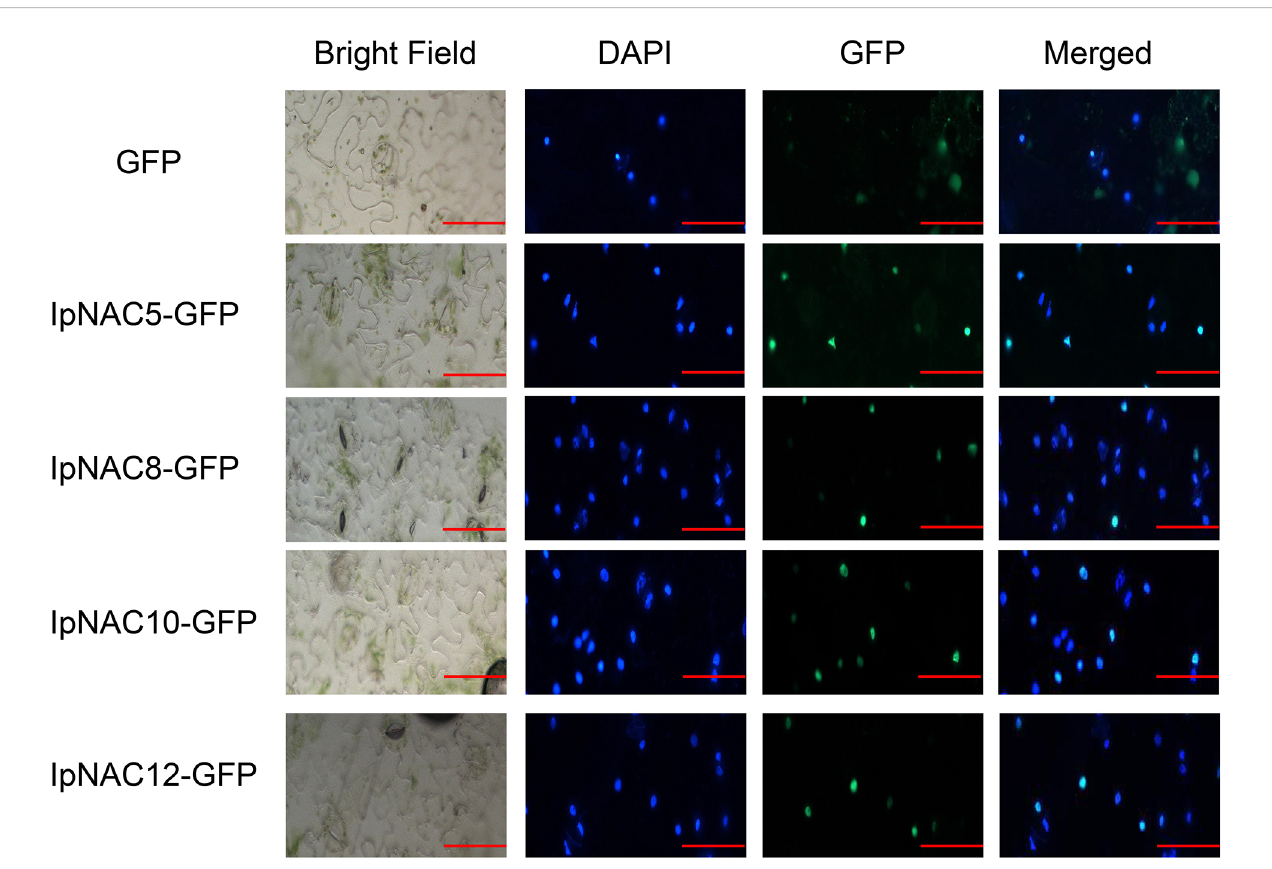
FIGURE 7 Subcellular localization of IpNAC5/8/10/12 in tobacco cells. IpNAC5/8/10/12-GFP and PHB-GFP were transiently expressed in tobacco. GFP fl uorescence was observed 2 d after infection by 10 × 20-fold laser scanning. Photos were taken under bright and dark light for the detection of green fl uorescent protein (GFP), diamino-2-phenylindole (DAPI), and binding (merging). Bars = 30 m